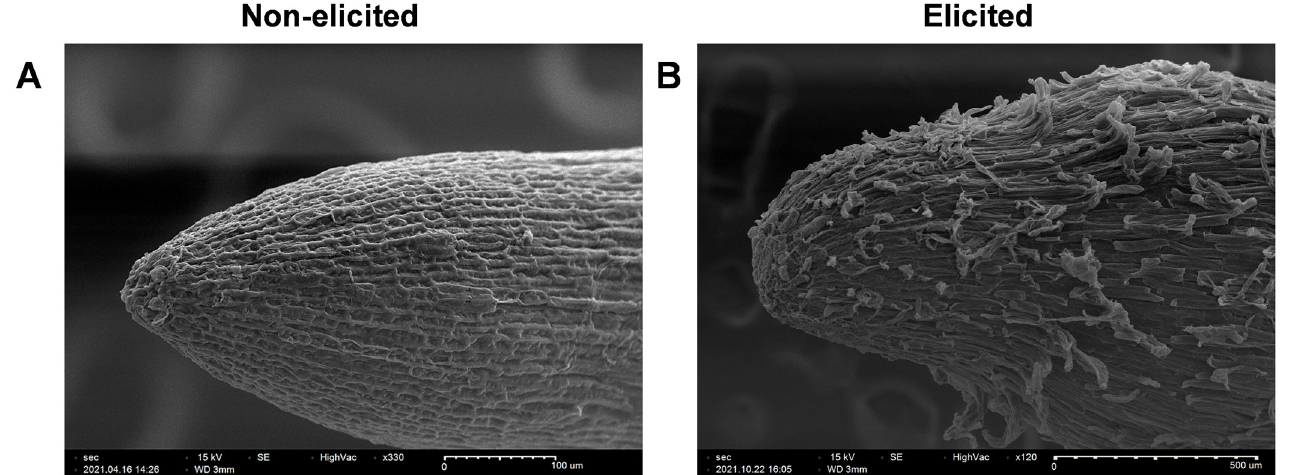
Figure 4. Scanning electron microscopy analysis of hairy roots of pigeon pea line G4: ( A ) Non-elicited under × 330 magnification and ( B ) elicited for 144 h under × 120 magnification.